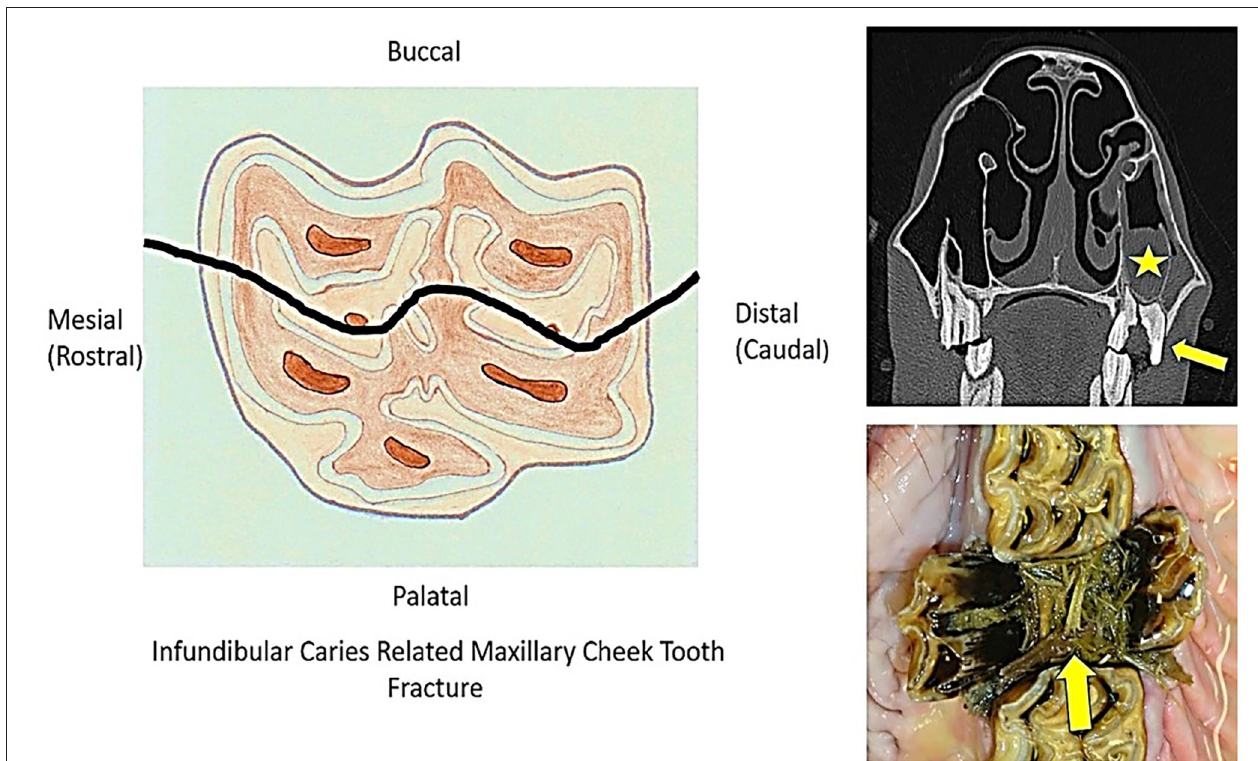
FIGURE 1 | The diagram on the left shows the fracture plane through both infundibula (that would have advanced caries and likely coalescence of both infundibula before fracturing). The top right image shows a transverse computed tomographic image of an aged Triadan 209 with a midline infundibular caries-related sagittal fracture (arrow) with resultant apical infection and maxillary sinusitis (star). The bottom right image shows a postmortem image of an infundibular caries-related midline sagittal Triadan 109 fracture with palatal and buccal displacement of the two fracture fragments and food impaction in the fracture site